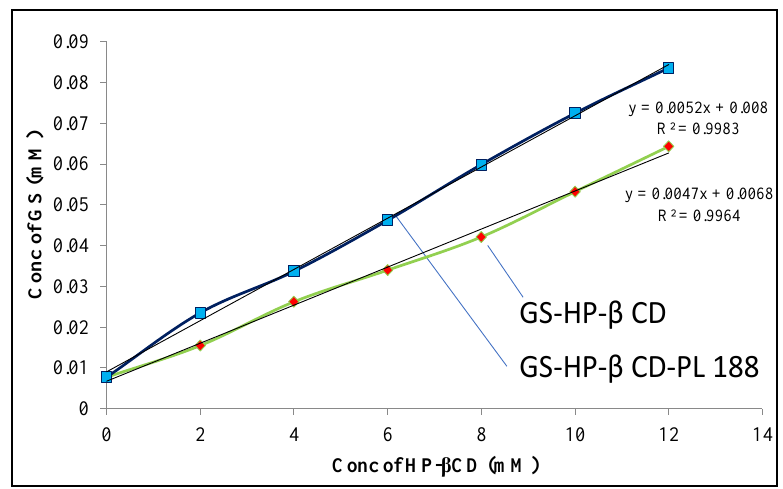
Figure 2. Phase solubility of Genistein—HP β CD and Genistein—HP β CD-PL 188. The saturated solubility of GS was found to be 2.09 µ g/mL which is agreed with the reported value (2.03 µ g/mL) [8]. The order of solubility found as follows GS TC > GS-BC >